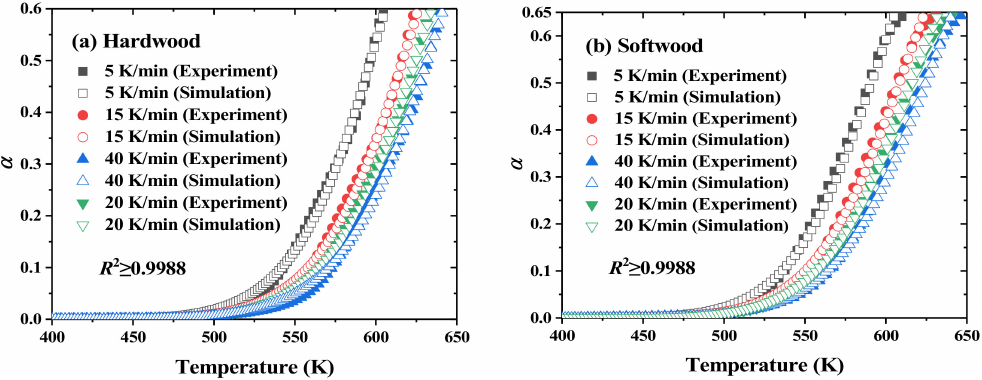
Figure 7. Comparison of the experiment with simulation at multiple heating rates.